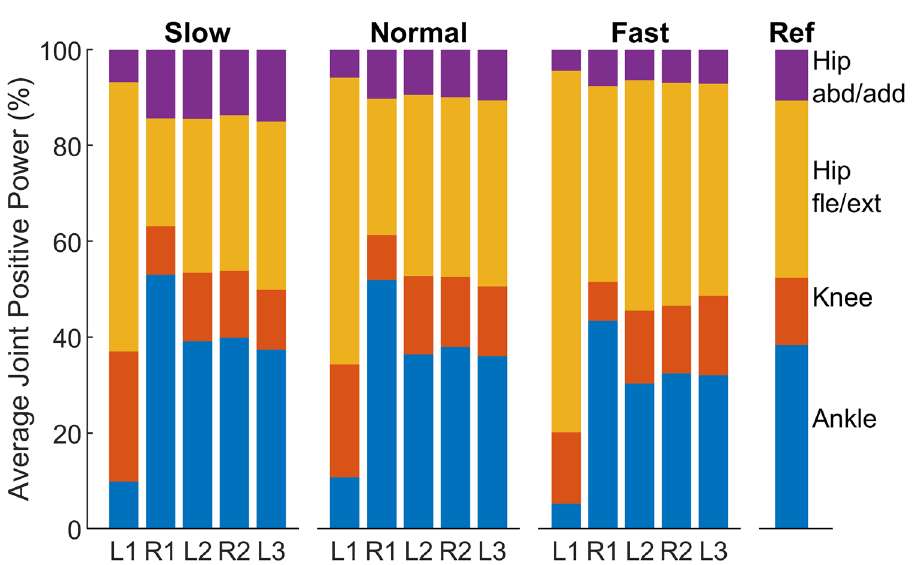
Figure 4. Relative contribution of the average positive joint power for the first five strides of slow, normal and fast gait initiation and for the reference trials (Ref). Purple indicates the hip abduction/adduction joint. Yellow indicates the hip flexion/extension joint. Orange indicates the knee flexion/extension. Blue indicates the ankle plantarflexion and